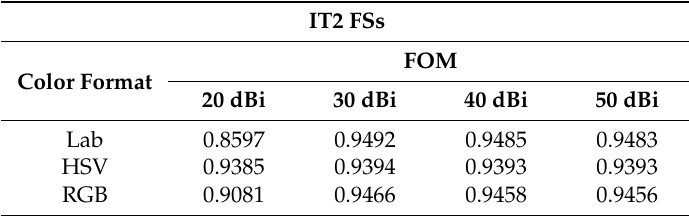
Table 8. FOM values achieved by IT2 FSs in images with Gaussian noise.